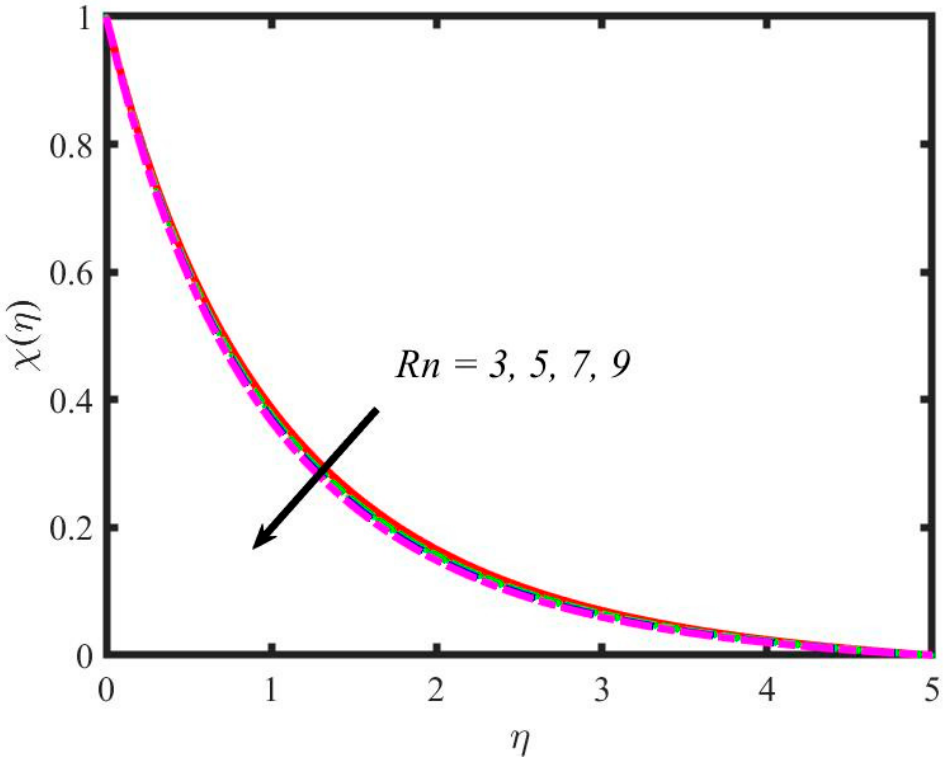
Figure 21. Variations in microorganism profile for activation energy parameter.